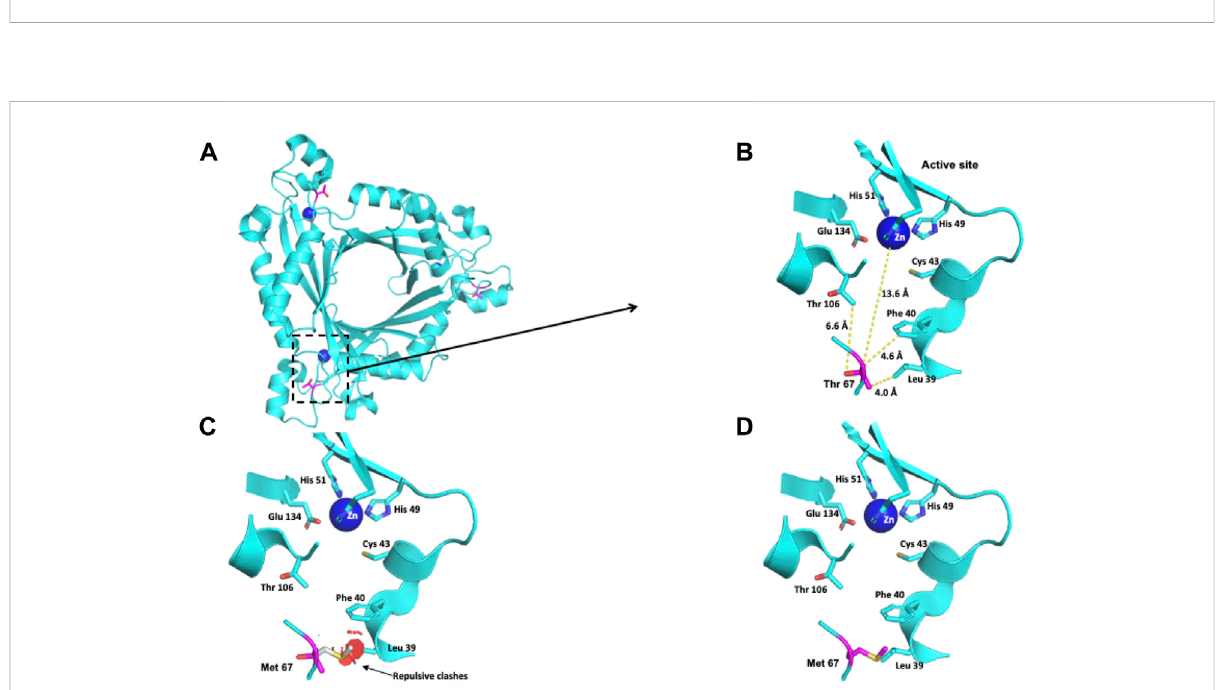
FIGURE 2 Modeling of the human PTPS structure with p.(Thr67Met) change. (A) Crystallographic structure of a trimer of PTPS and location of the Thr 67 residues on each monomer. (B) Location of the Thr 67 residue in one monomer. (C – D) Potential pathogenic effects for the substitution of Thr by